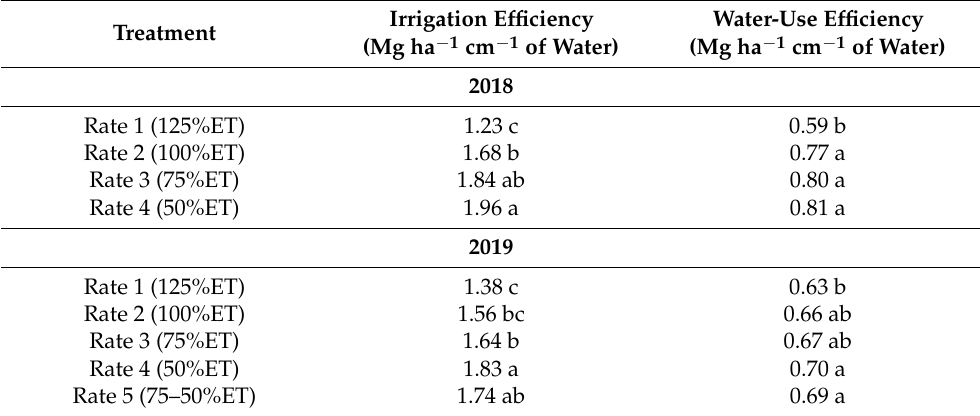
Table 4. Effects of irrigation rate on irrigation efficiency (IE) and water-use efficiency (WUE) for producing total yield in 2018 and 2019. Within each year and efficiency type, numbers followed by different letters are significantly different at α = 0.05.